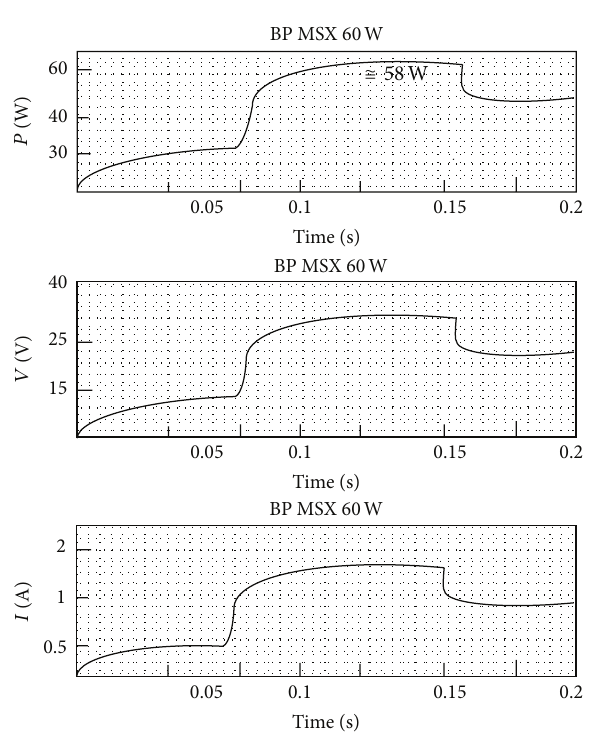
Figure 22: Tracking of maximum power, voltage, and current with respect to different irradiations for BP MSX 60